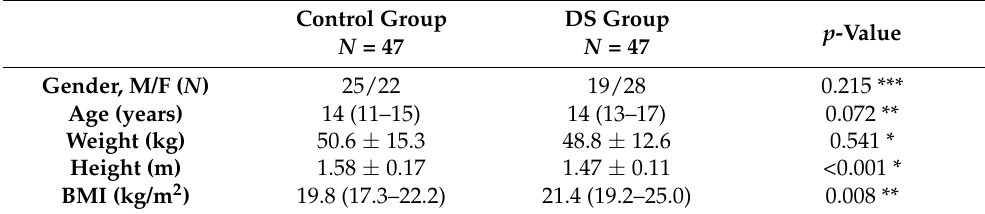
Table 1. Baseline characteristics of patients with (DS group) and without Down syndrome (con- trol group). Control Group DS Group p -Value N = 47 N = 47 Gender, M/F ( N ) 25/22